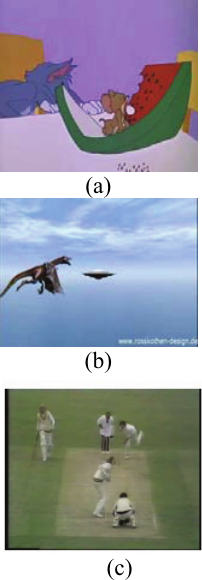
Fig. 5.3 spatial feature extraction (a) keyframe corresponding (b) re-sampled frame (c) re-sampled frame alienated into